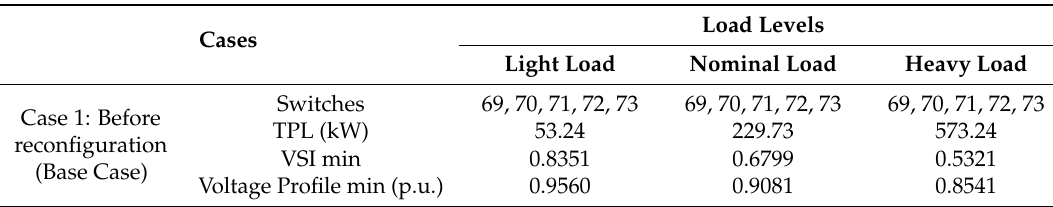
Table 5. Base case at different load conditions for 69-bus